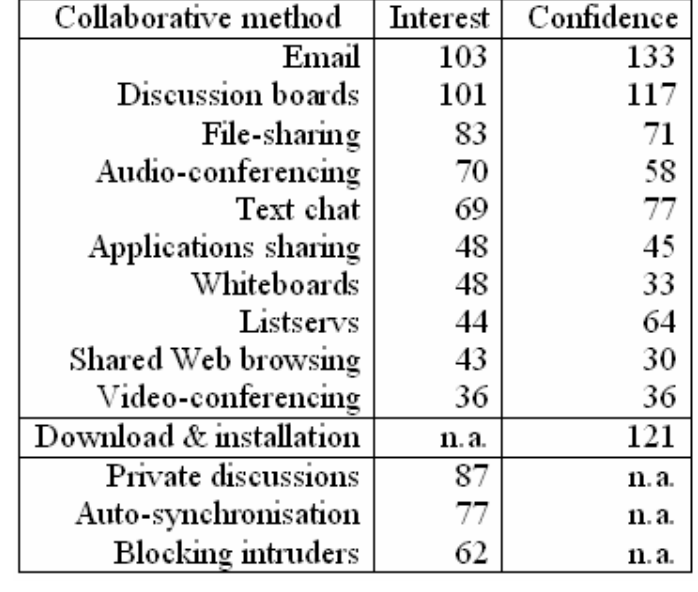
Table 1. Number of respondents who expressed interest and confidence in the use of Online Collaboration